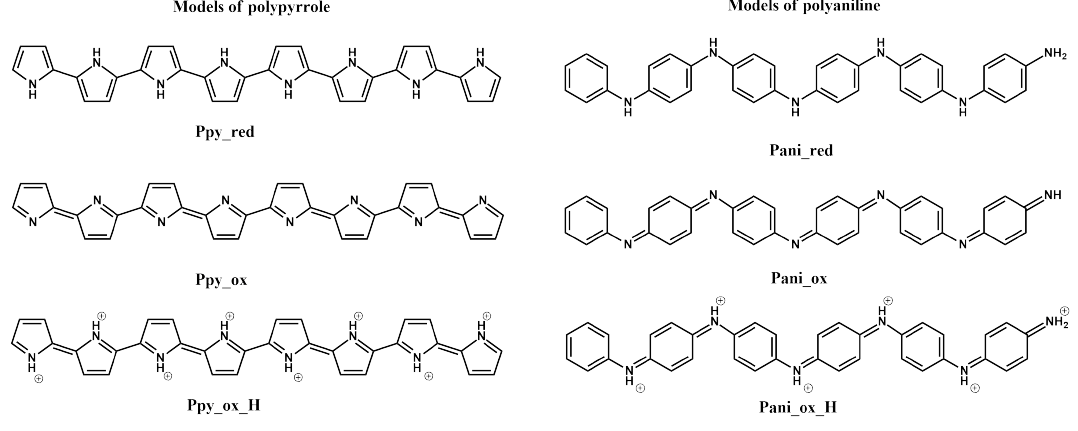
Figure 1. Structures of polypyrrole and polyaniline